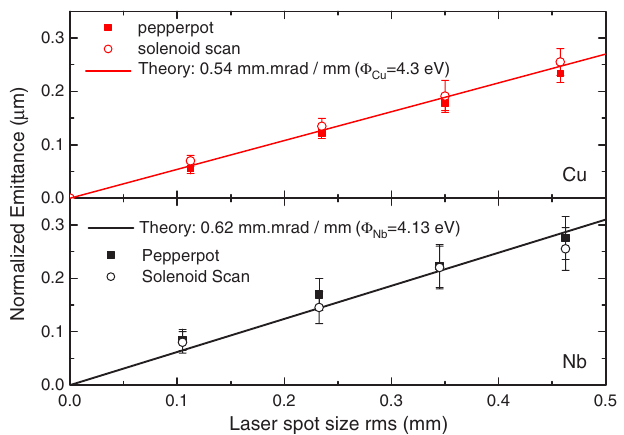
FIG. 15. Charge versus gradient on a copper insert ( (cid:6) ¼ ¼ 79 (cid:1) J ; (cid:5) mc 2 ¼ 5 : 76 MeV ; (cid:2) ¼ 262 nm , E t; laser 262 nm ¼ 1 : 8 mm ; g ¼ 6 mm ). Space charge limited 4 : 2 ps ; D laser ¼ 1 : 08 mm (see text); pho- emission [Eq. (15)] assuming D laser ton limited emission theory corresponds to Eq. (10) of Ref. [37] ¼ 4 : 75 eV assuming (cid:2) Cu